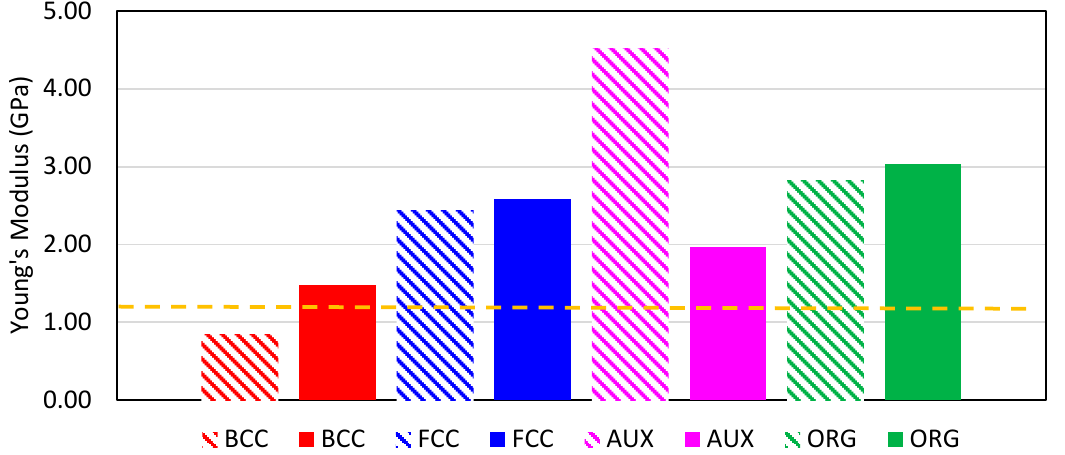
Figure 20. Comparison of bulk Young’s moduli for the four lattice architectures, determined by simulation (diagonal patterned) and experimental testing (solid colors).